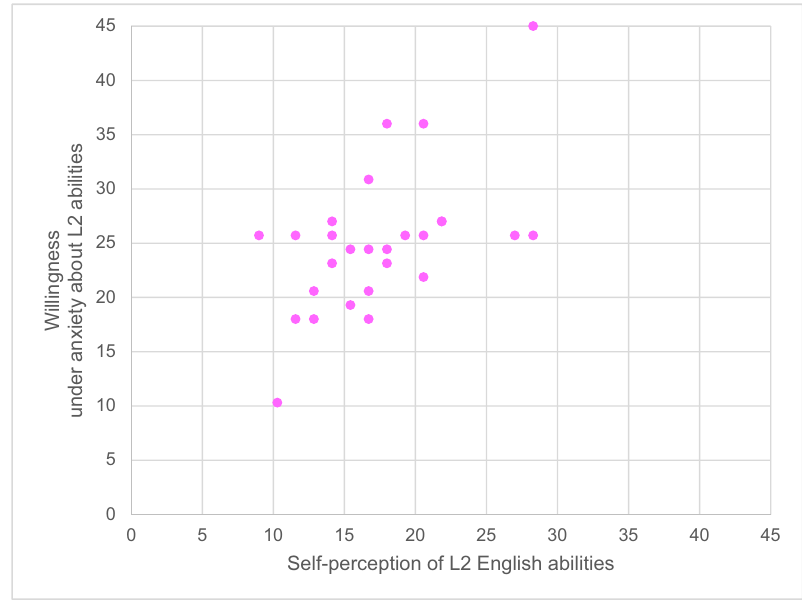
Figure 4: Correlation between willingness under anxiety about L2 abilities and self - perception of L2 abilities ( Likert points ) .